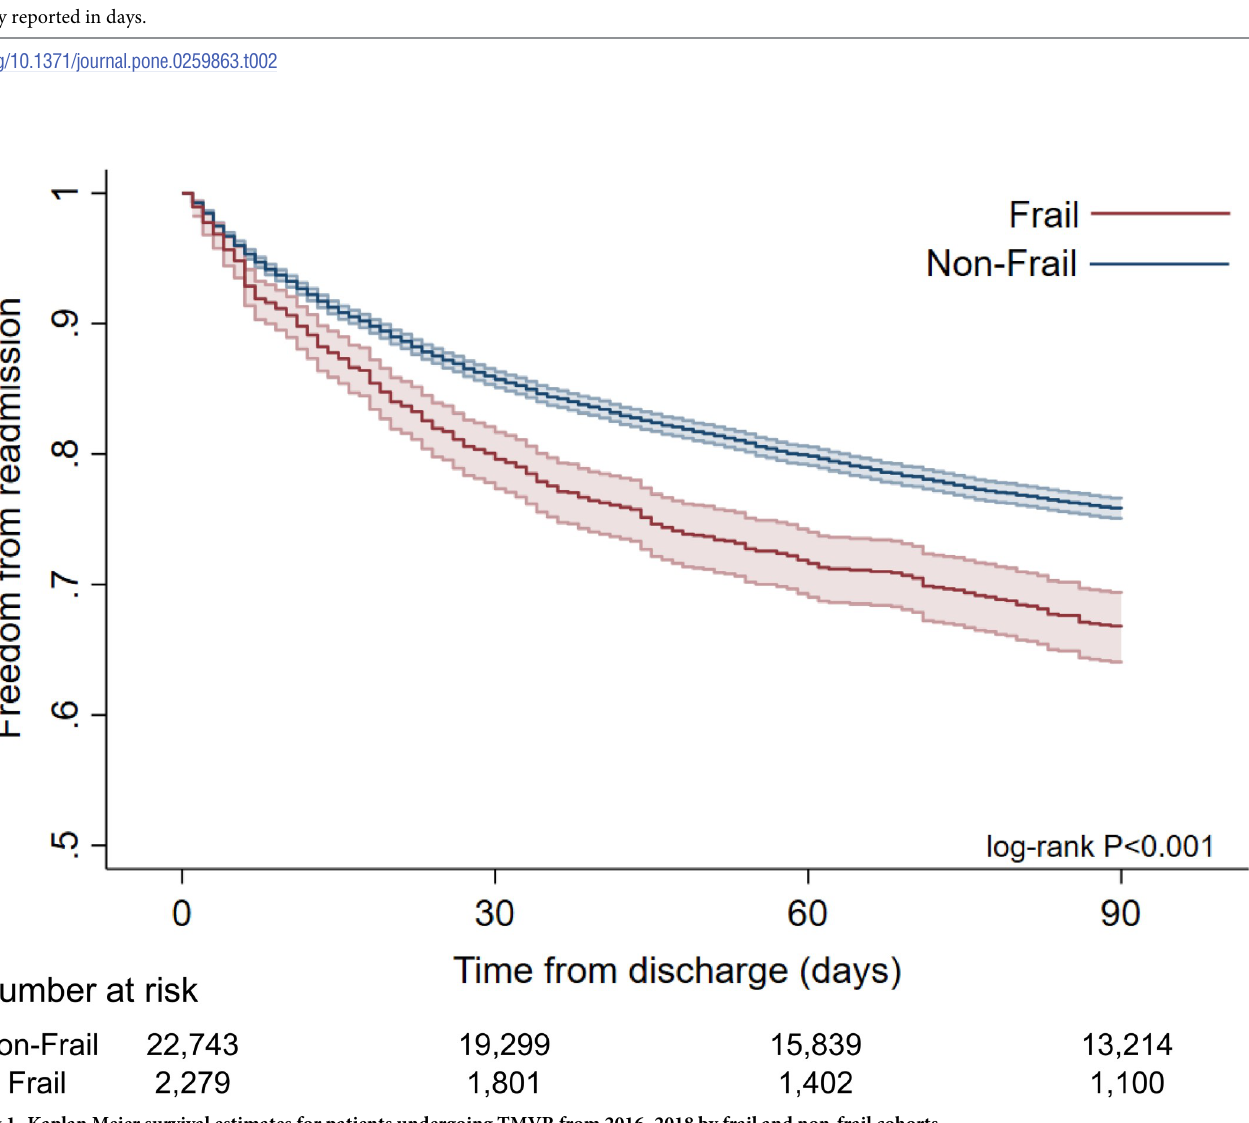
Fig 1. Kaplan Meier survival estimates for patients undergoing TMVR from 2016–2018 by frail and non-frail cohorts.